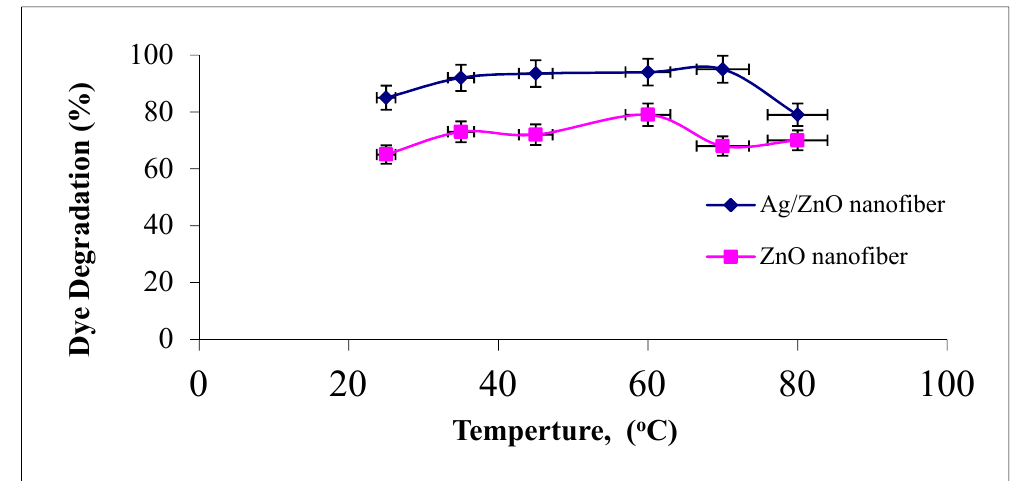
Figure 10. Effect of dye solution temperature on the MG dye photocatalytic degradation process using ZnO polymeric nanofibers after and before silver immobilization (initial dye concentration = 20 ppm, nanofiberdose = 0.1 g, contact time = 60 min at pH = 7).